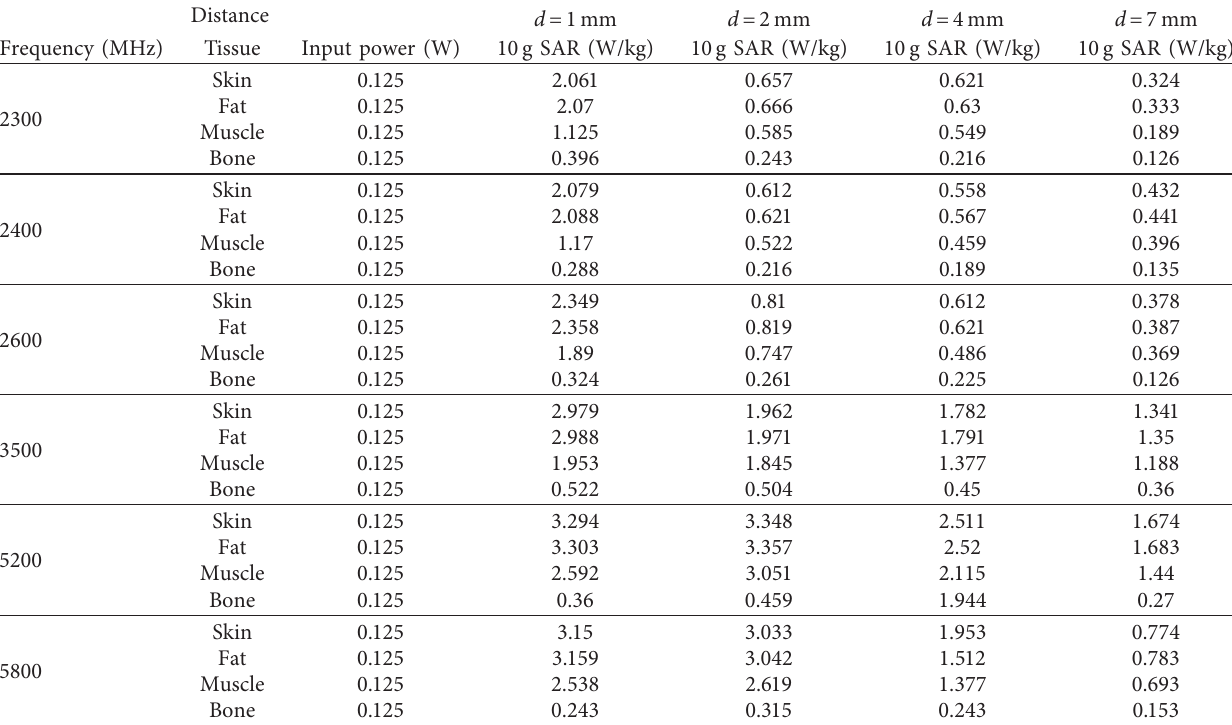
Table 5: Maximum SAR results of the antenna mounted on wrist